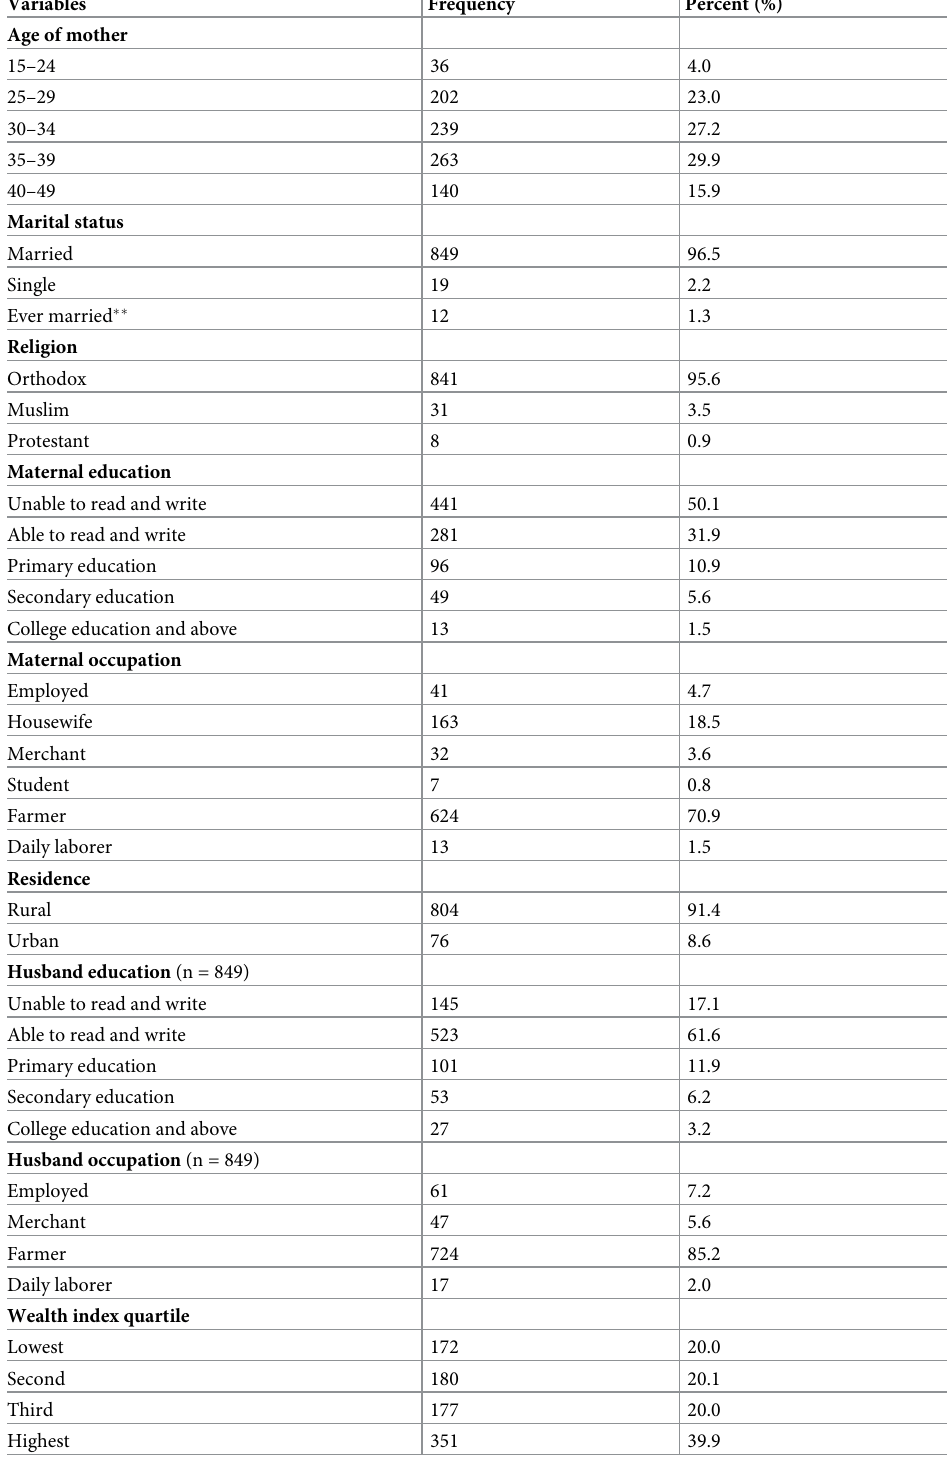
Table 1. Socio-demographic characteristic of study participants in Dembecha district, Northwest Ethiopia, 2019 (n =